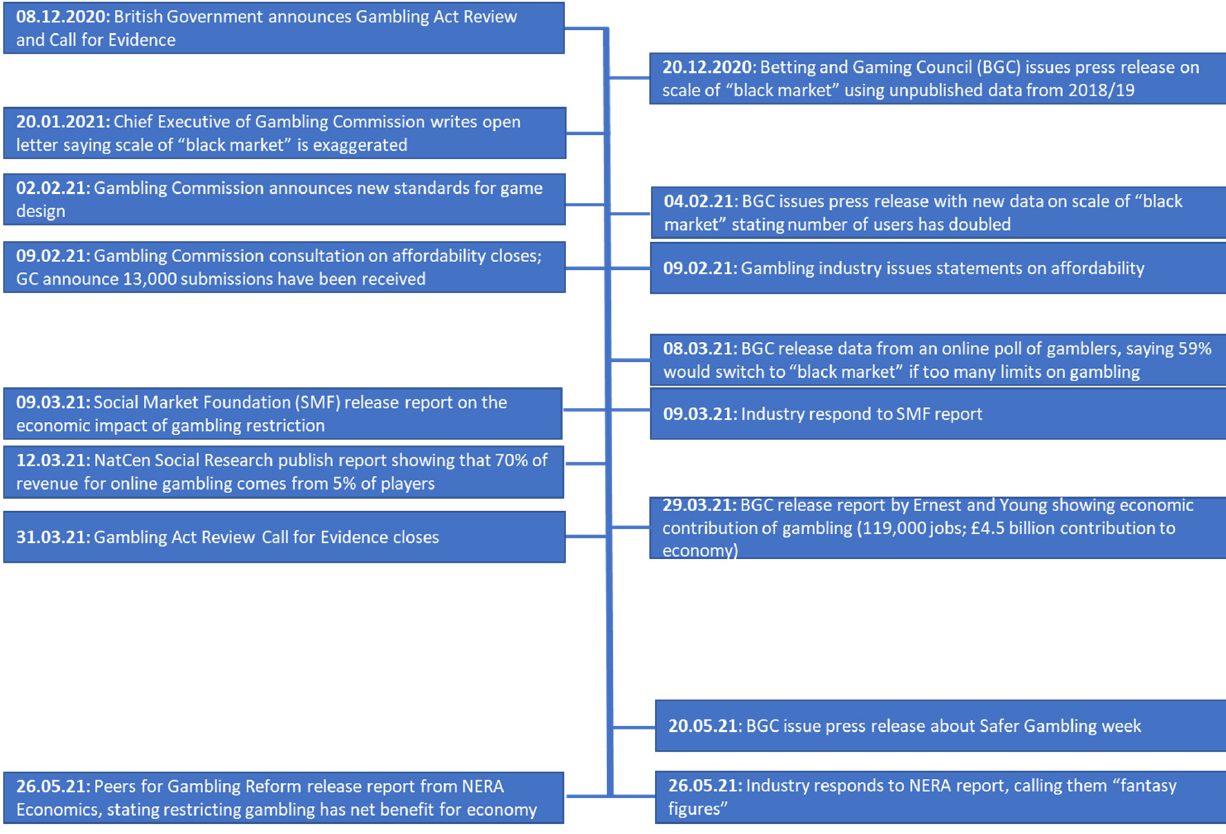
Figure 1. Timeline of key events .